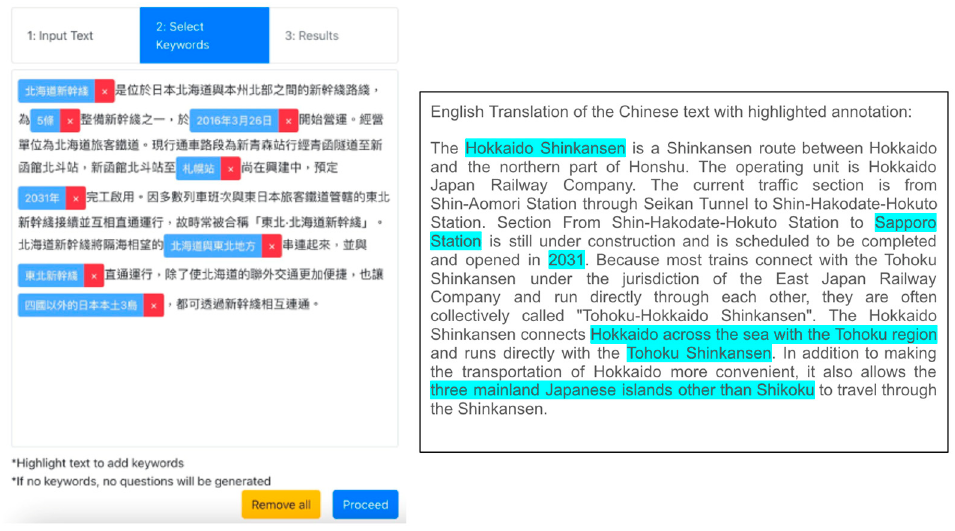
Figure 3. Step 2: possible answer phrases are pre-annotated.